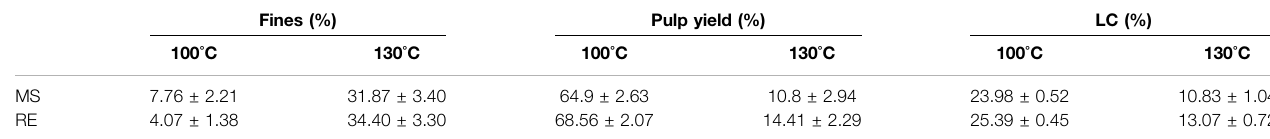
TABLE 1 | Yields and standard deviation obtained from the Duplo experiments at 100 and 130 ° C in both setups during 1 h of cooking at the L/W of 27:1.